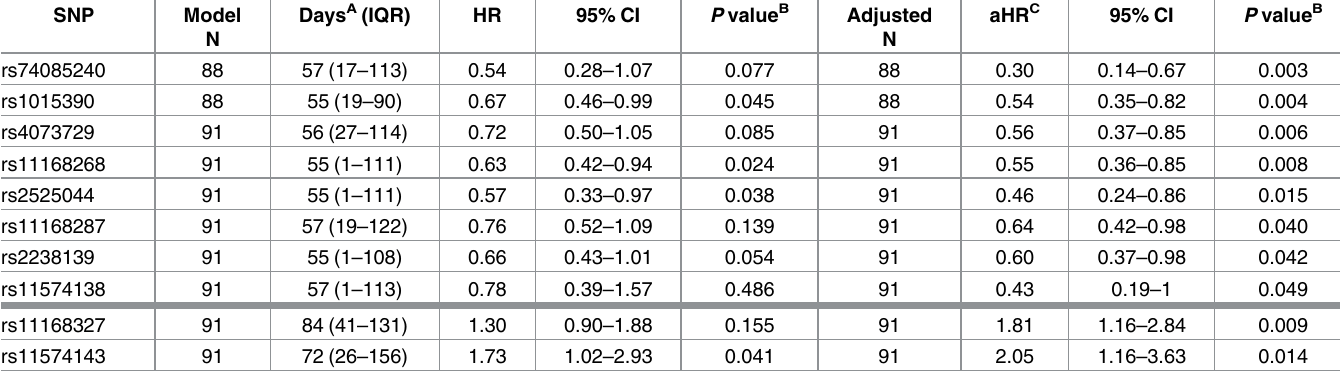
Table 2. Hazard of sputum culture conversion by vitamin D receptor gene single nucleotide polymorphism.